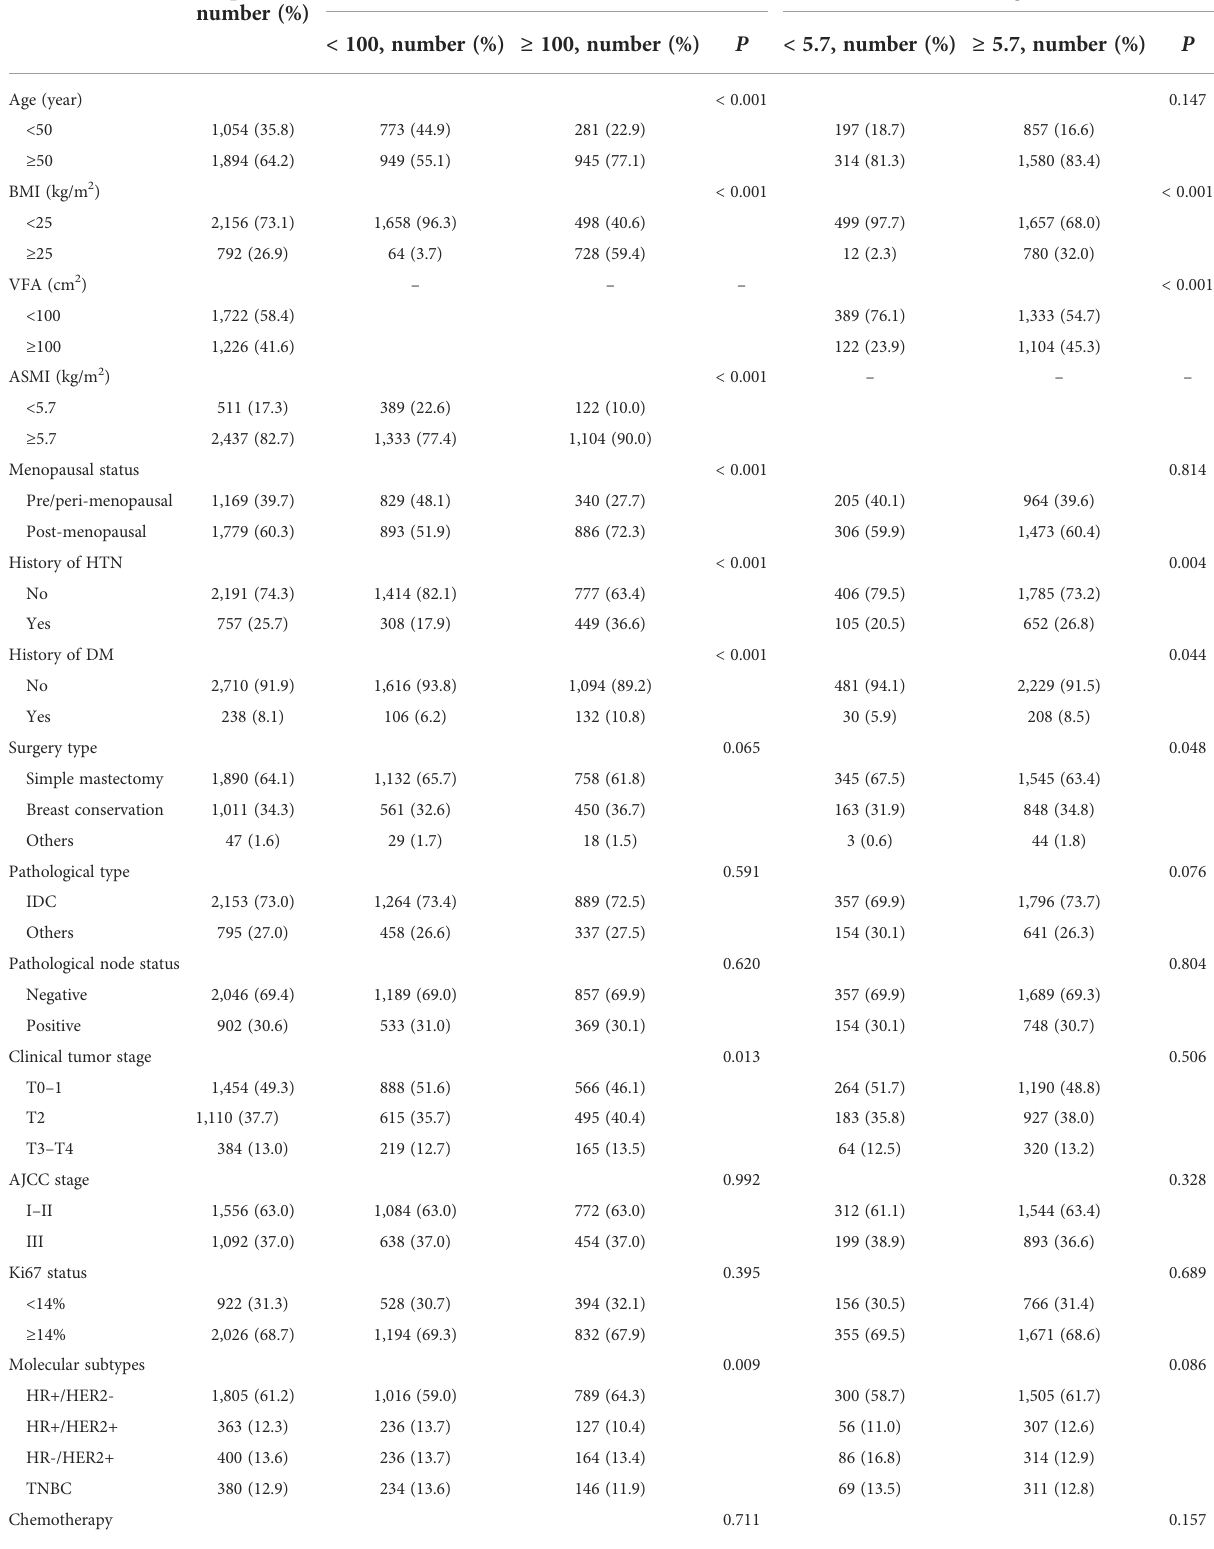
TABLE 1 Baseline characteristics of 2,948 patients with breast cancer strati fi ed by VFA and ASMI.